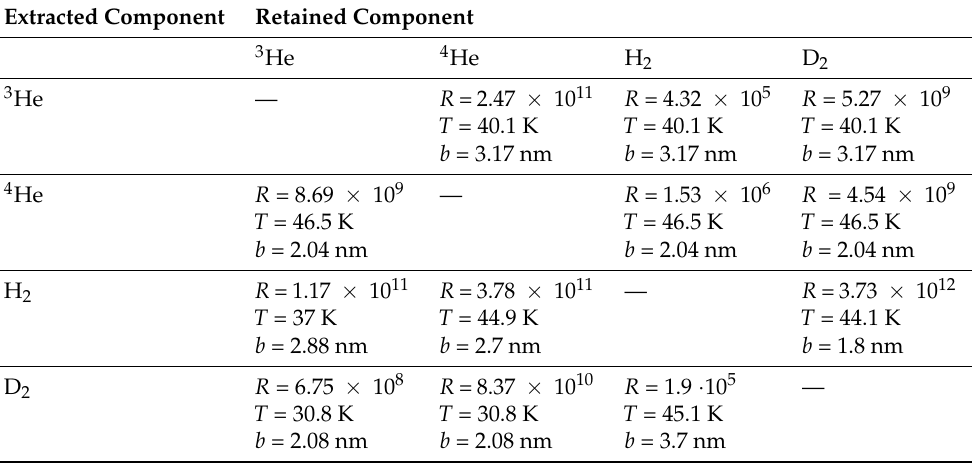
Table 1. The parameters that provide the maximum separation degree of light isotope mixture. Extracted Component Retained